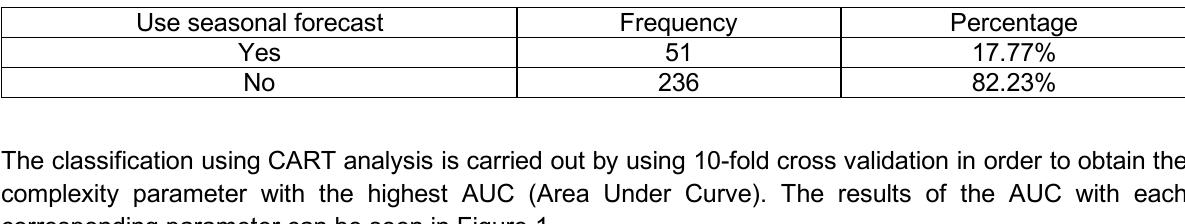
Table 3: Proportion of class